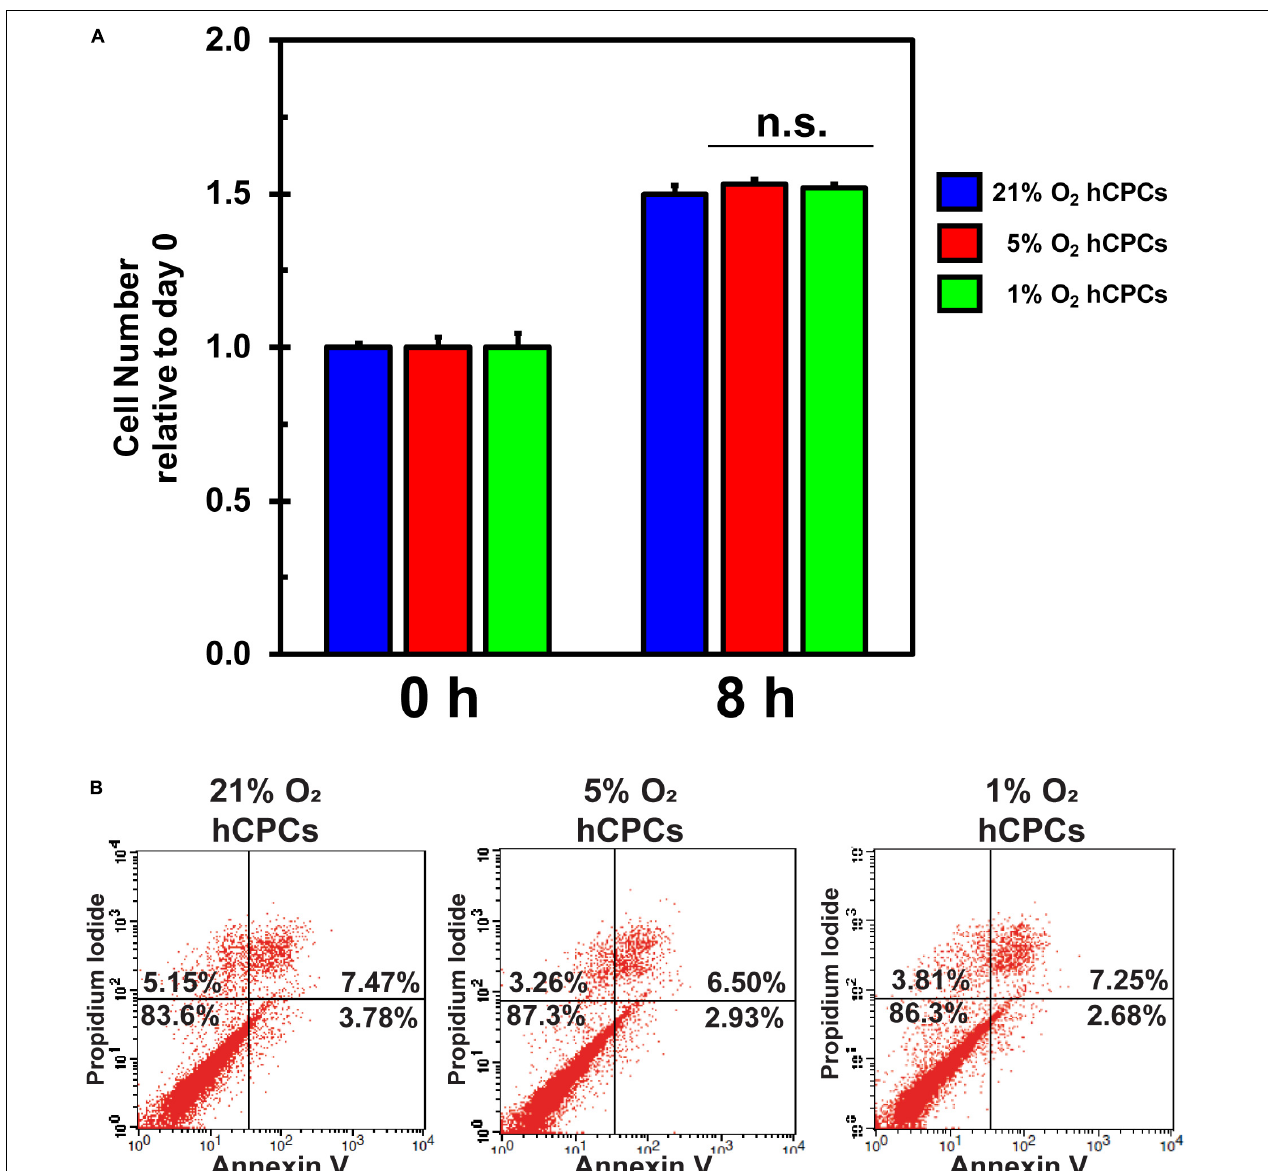
FIGURE 2 | hCPCs maintain normal function under hypoxia. hCPCs were cultured under 21, 5, and 1% O 2 . (A) XTT assay for cell proliferation shows that cells maintained a similar level of proliferation over 24 h. Data represents mean ± SD, n = 4. (B) Flow cytometry for Annexin V/PI show that cells are equally healthy under the various oxygen conditions as the number of non-apoptotic/non-necrotic cells remains similar after 48 h of culture.